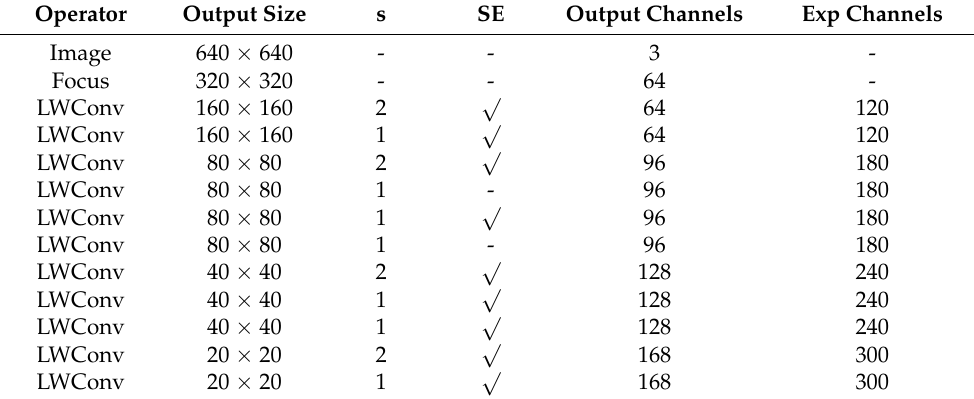
Table 3. Specification for the BLWNet-Small.